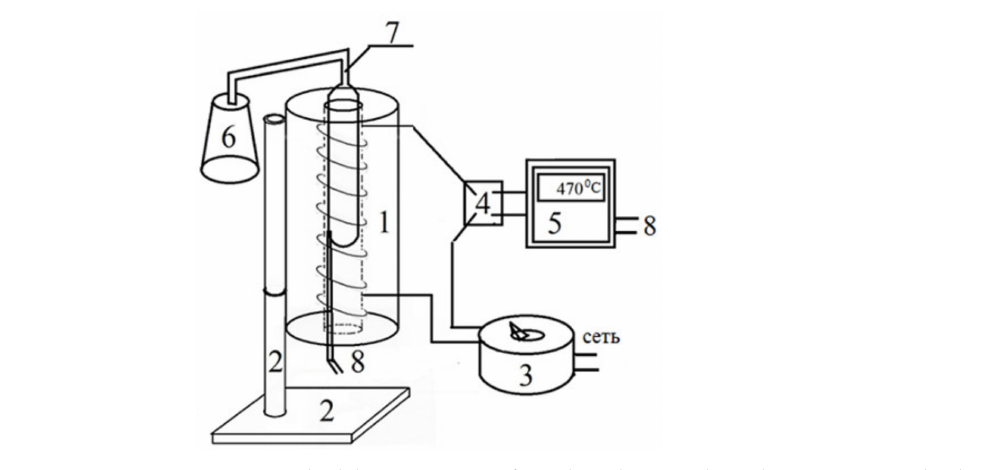
Figure 1. The laboratory setup for coking heavy oil residues: reactor and coking oven (1); furnace mounting bracket (2); step-down voltage transformer (3); relay switch (4); temperature control controller (5); receiving container for distillate (6); container for loading raw materials (7); and thermocouple (8).